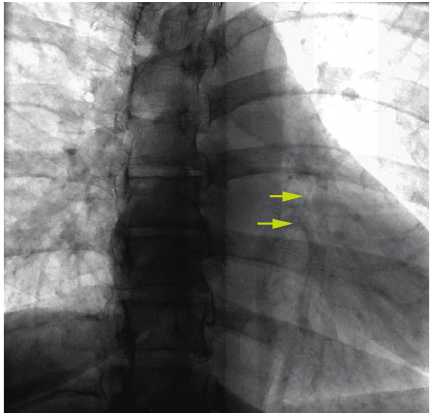
Figure 2: Fluoroscopy at the time of retrieval. Coned view of the heart faintly visualizes the dislodged catheter